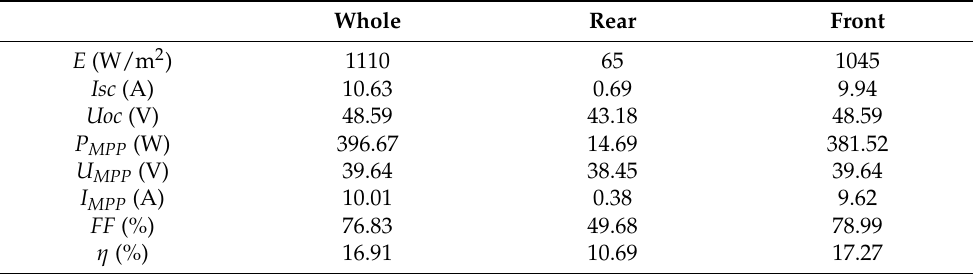
Figure 16. The whole vs. rear side yield characteristics benchmark in a bifacial module: ( a ) current- voltage characteristics; ( b ) power-voltage characteristics for 60° inclination over the white substrates. Table 16. The measurements results and calculations for 60 ◦ inclination of the module over the white substrate, considering the values for the whole-module generation and its rear side generation.